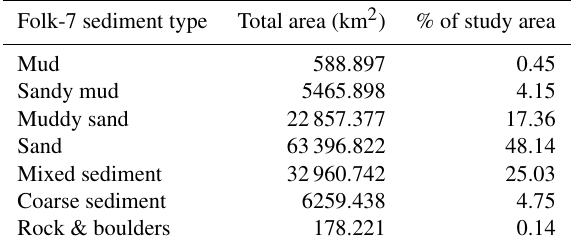
Figure 3. Sediment property interpolation and rescaling re- sults. (a) EBK interpolation results for critical bed shear stress. (b) Rescaling results for the critical bed shear stress raster. (c) EBK interpolation results for angle of repose. (d) Rescaling results for the angle of repose